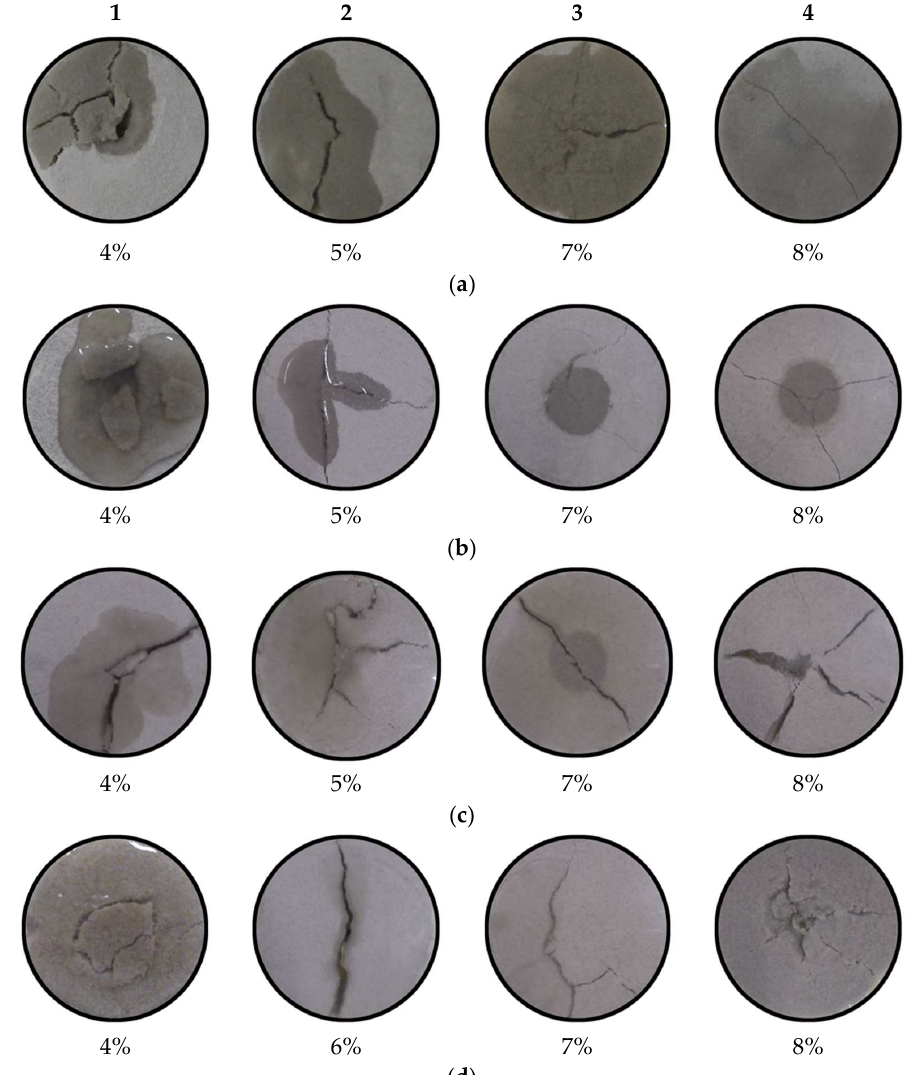
Figure 3. Example snapshots of the fractures immediately after the failure appeared during glycerine injection experiments in fine bio-cemented sands across various cementation levels (3% to 8%, increasing from left to right) at ( a ) 30 mL/min, ( b ) 100 mL/min, ( c ) 200 mL/min, and ( d ) 400 mL/min. Features became more pronounced as the flow rate increased, with grains moving in clusters for lower cementations in all flow rates. As the flow rate increased (moving down from row a to row d), the infiltration zone became smaller and more symmetrical and the fractures appeared to grow ahead of the infiltration zone. The breakdown pressures con- tinued to grow once a crack or cavity appeared, and the degree of damage was of larger extent, resulting in a sudden fracture extending further away from the infiltration zone. This behaviour was not captured in any tests presented in the literature, as the infiltration zone always was interpreted as preceding the fracture. However, in most of the tests in 3D materials presented previously, the fracture was observed after the end of the test. At 400 mL/min (row d), a process zone was evident, which was around the fracture resem- bling the viscosity fingering-dominated regime (regime IV) of the 2D Hele-Shaw setup experiments by Huang et al. [55]. As in the study of Huang et al. [55], it may be assumed that the capillary effect is negligible in the presented experiments since the capillary